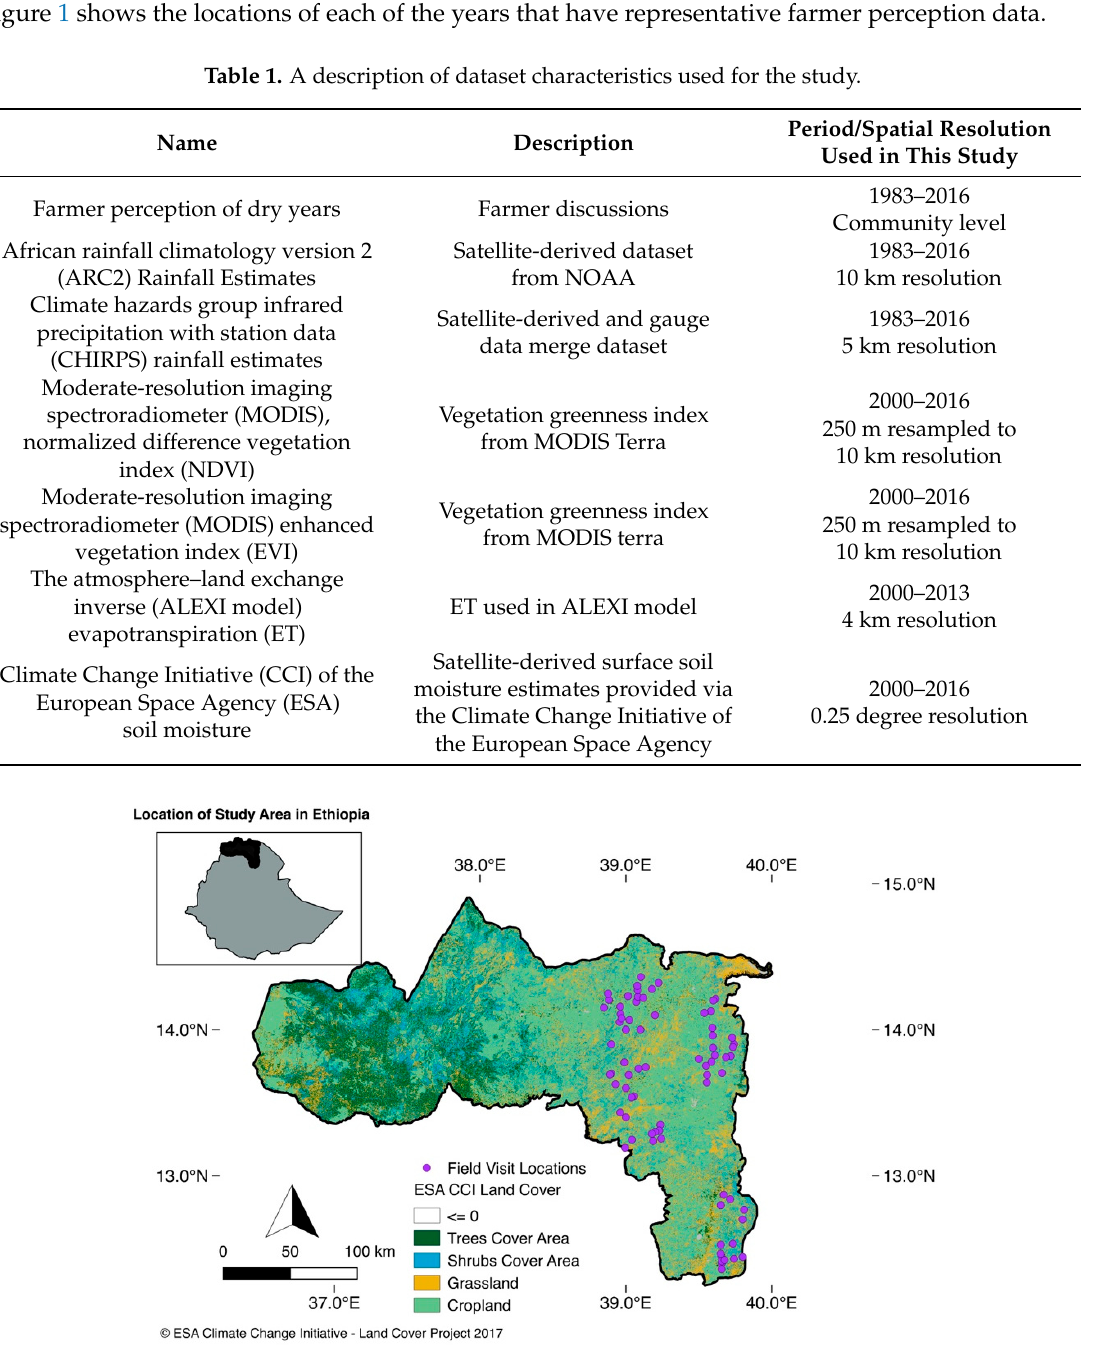
Figure 1. Tigray, Ethiopia land cover with locations of field visits.